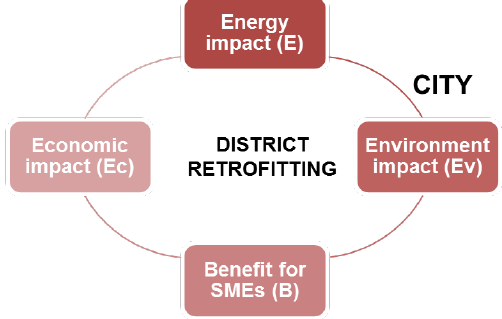
Figure 7. Type of impacts evaluated in the assessment